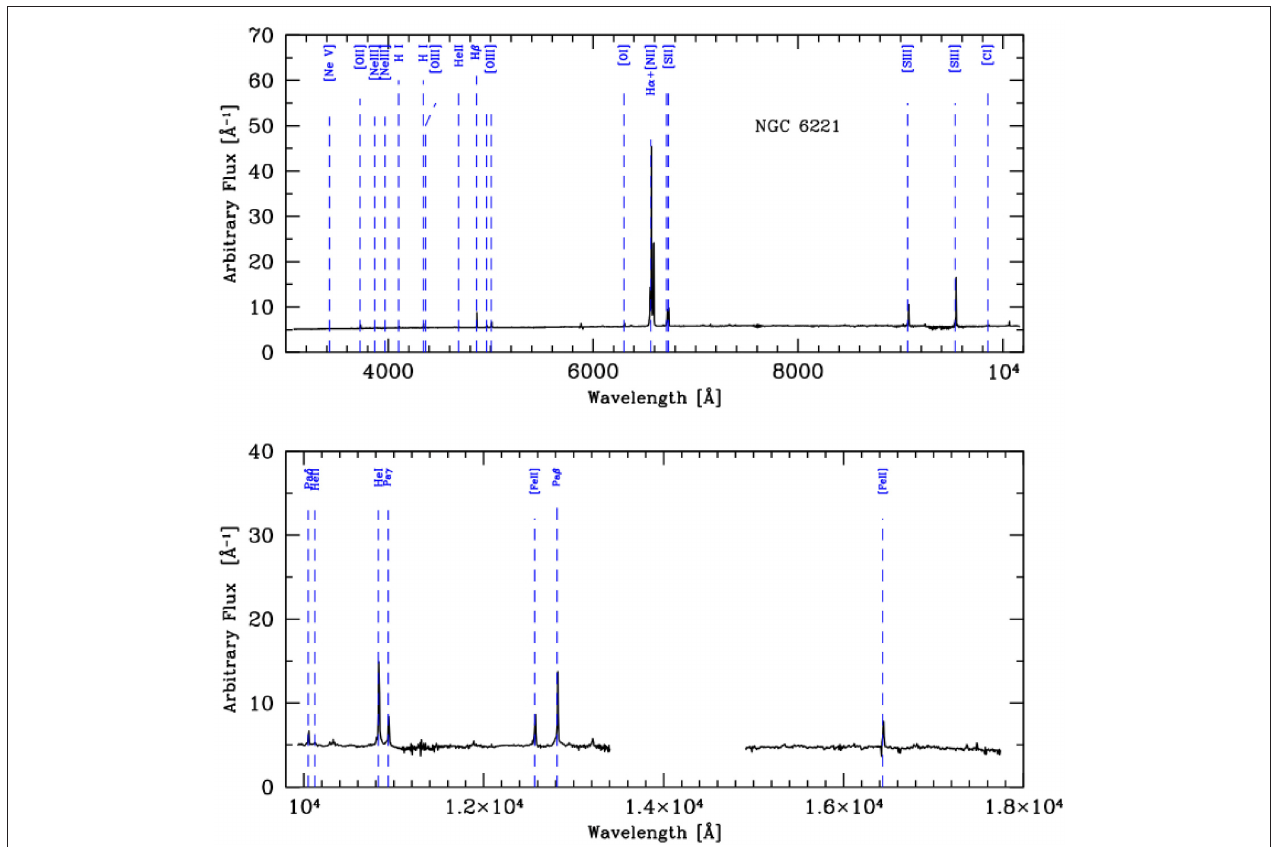
FIGURE 1 | UV, Optical, and Near infrared rest frame spectrum of NGC 6221 obtained with X-Shooter/VLT. The blue dashed lines show the expected wavelength position of the most relevant emission lines.